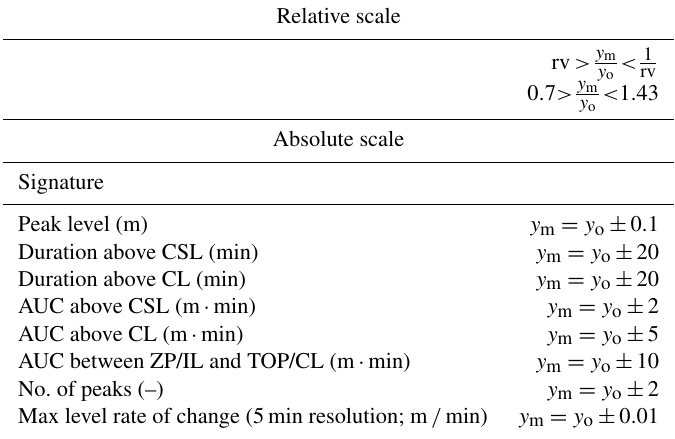
Table 2. Values representing the acceptance criteria for different signatures. The acceptance bounds are based on the combination of both the relative and absolute acceptance criteria. The absolute values relate to the 1 : 1 line, and the relative scale gives the slope range of acceptance. rv is the relative value which is, in this case, set to 0.7, y m is the modelled signature value, and y o is the observed signature value.